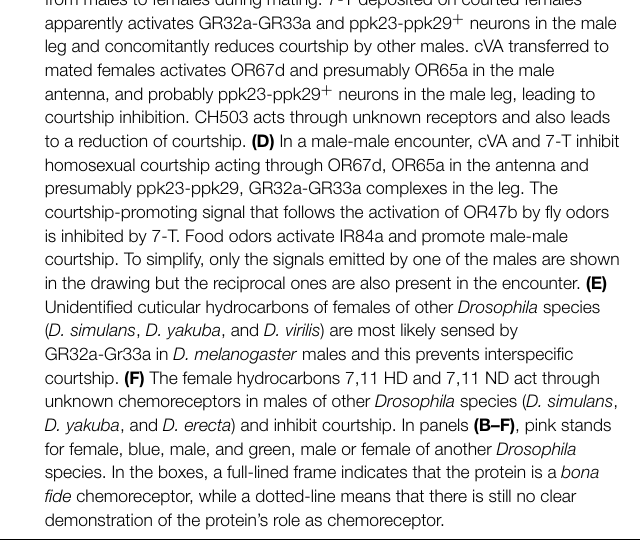
FIGURE 2 | Chemoreceptors involved in sexual behavior. (A) Sexual dimorphism in chemoreceptor’s expression and in neuronal morphology of the chemosensory system of the leg. Male legs express more ppk23 + , ppk25 + , ppk29 + FruM + , and IR52a + , IR52c-IR52d + sensory neurons than female legs. In males, axons of ppk23 + neurons cross the ventral nerve cord midline in the thoracic ganglion (TG), whereas female axons do not. GR68a is only expressed in male legs, while GR32a and GR33a are expressed in the same number of leg sensory neurons in both sexes. Sexual dimorphism is observed in the dendritic arbor of the GR32a postsynaptic neurons expressing Fru in the SOG. (B–F) Illustrations of olfactory and gustatory cues (sexual pheromones or food odors) and the chemoreceptors involved in sexual behavior during an encounter between a virgin female and a male (B) , a mated female and a male (C) , a male and another male (D) , and interspecific heterosexual encounters (E,F) . (B) Female hydrocarbons 7,11 HD and 7,11 ND activate most likely IR52c-IR52d, GR68a, GR39a, and the complex ppk23-ppk25-ppk29 in the male leg, and this induce courtship. Undetermined fly odors activate OR47b and OR88a, and at least the activation of OR47b leads to increase courtship in males. cVA produced by males stimulates OR67d receptors in female antenna and increase female receptivity. In addition to the signals produced by flies, food odors, in particular phenylacetic acid and phenylacetaldehyde, activate IR84a and promote courtship in males. (C) During courtship, males temporarily pass some 7-T hydrocarbon on to females, and cVA and CH503 are transferred